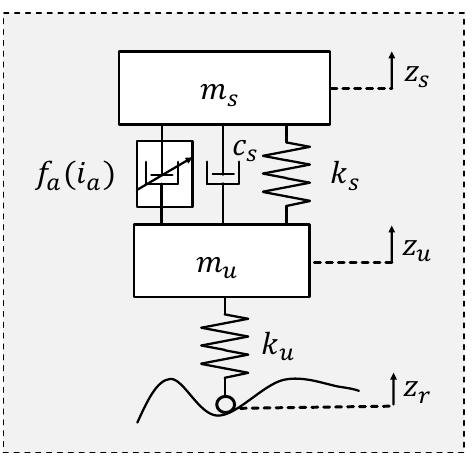
Figure 2. Vertical model of a quarter car with semi-active suspension